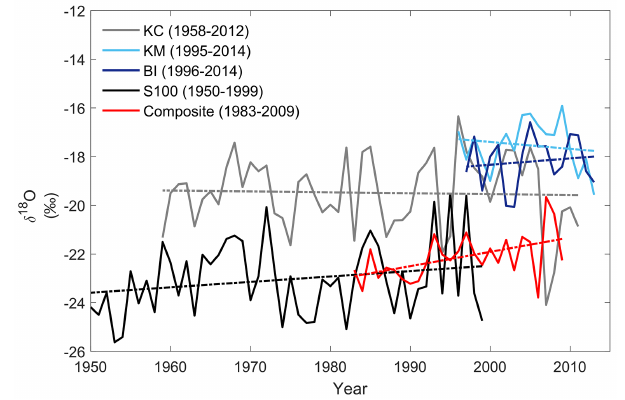
Figure 9. Mean annual δ 18 O for KC, KM, and BI compared to S100 (Divine et al., 2009) and the composite FIS core record (Schlosser et al., 2014). The dashed lines are the linear regression for the entire period covered by the respective